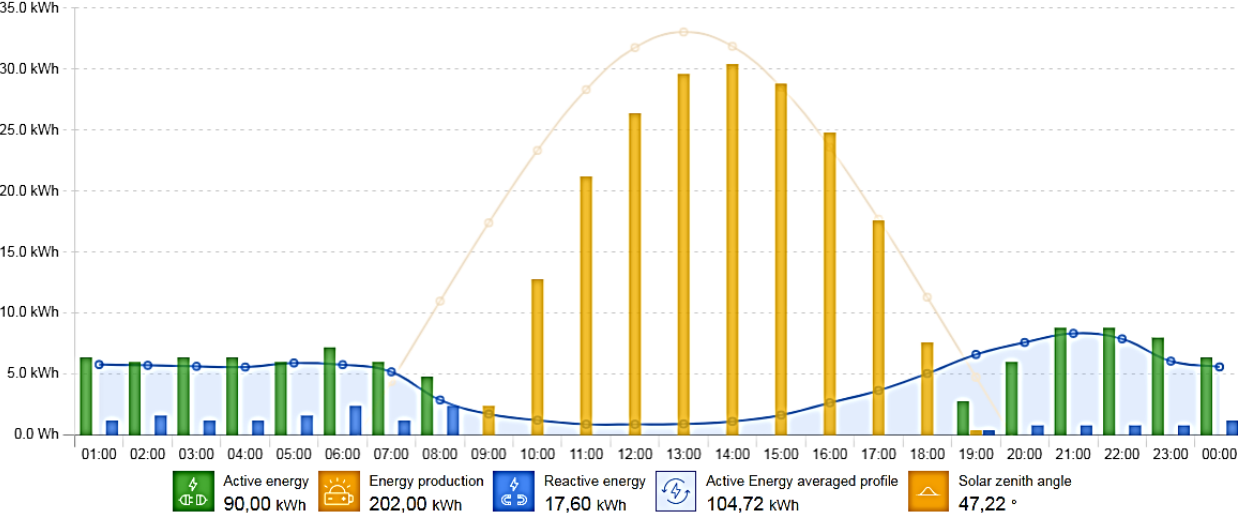
Figure 8. Energy flow in Sector 5 of the LSTP in 11 April 2020, energy consumed (active energy), and energy fed into the grid (energy production) and load demand pattern (blue line).